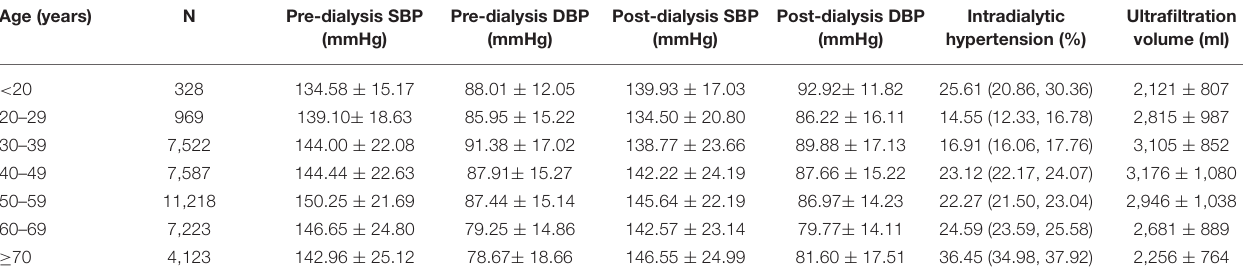
TABLE 4 | Pre-dialysis BP, post-dialysis BP, intradialytic hypertension, and HD UV according to different age groups. Age (years) N Pre-dialysis SBP